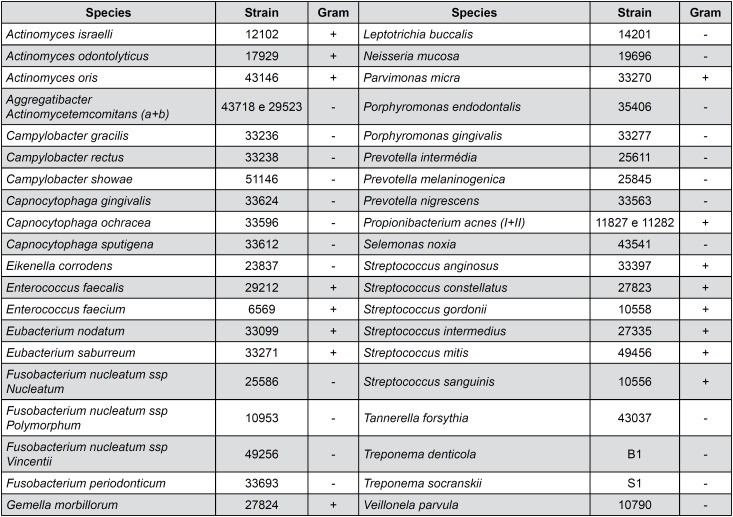
Bacterial strains used for the development of DNA probes